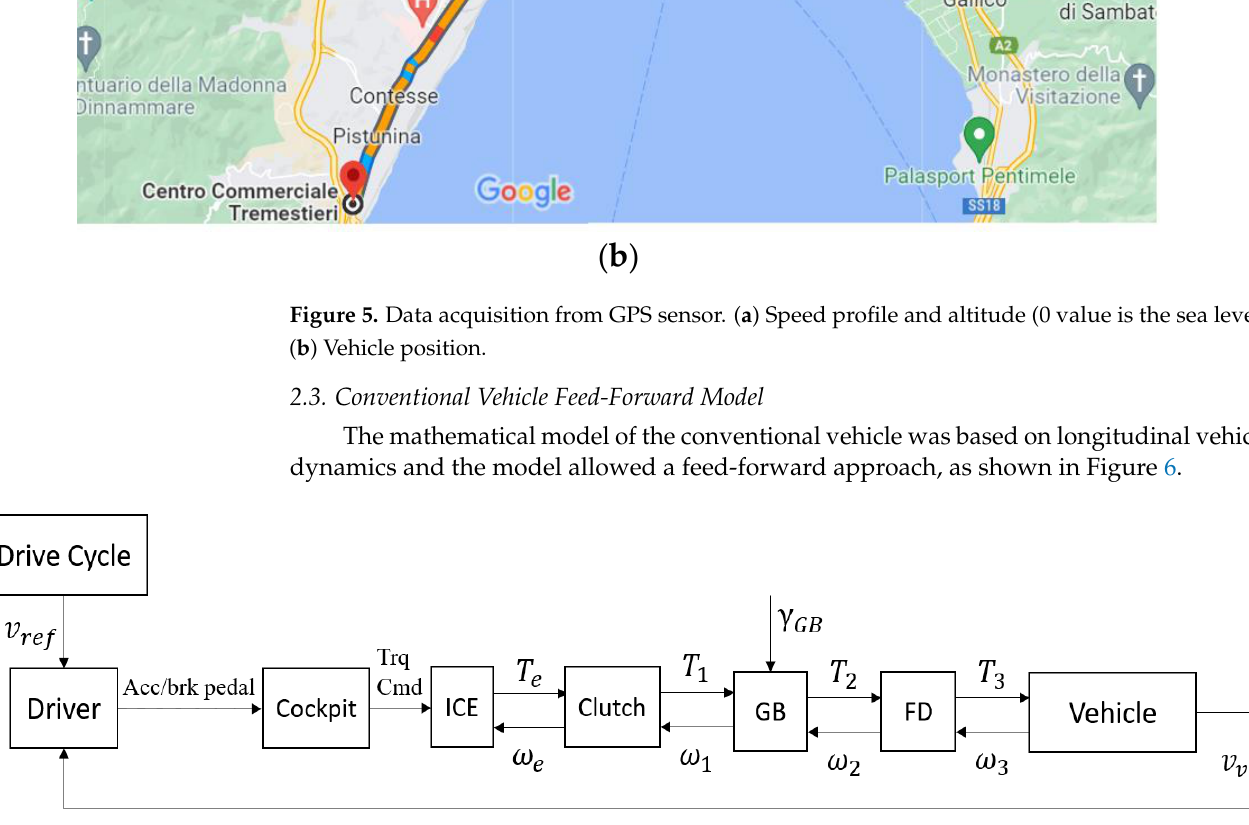
: gearbox gear ratio, 𝑣 : vehicle speed, 𝑣 : reference speed 𝐺𝐵 𝑣 𝑟𝑒𝑓